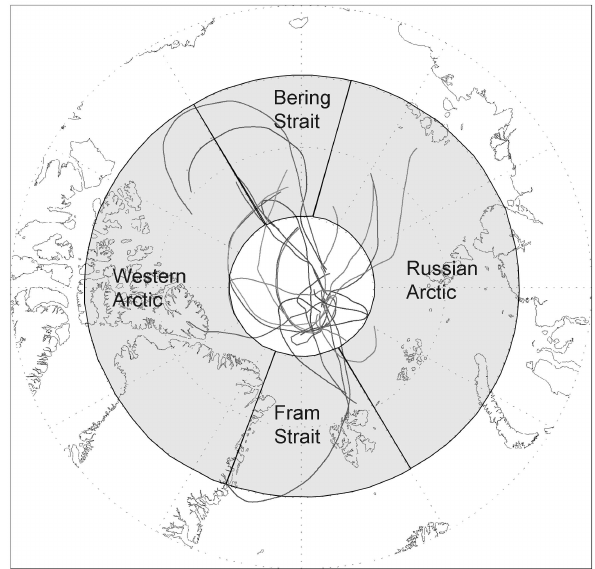
Fig. 9. 72h backward trajectories (black curves) for 25 LLJs ob- served at Tara. The air mass origins are divided into sectors: Fram Strait, Russian Arctic, Bering Strait, Western Arctic and the sector in the vicinity of the North Pole (northward of 85 ◦